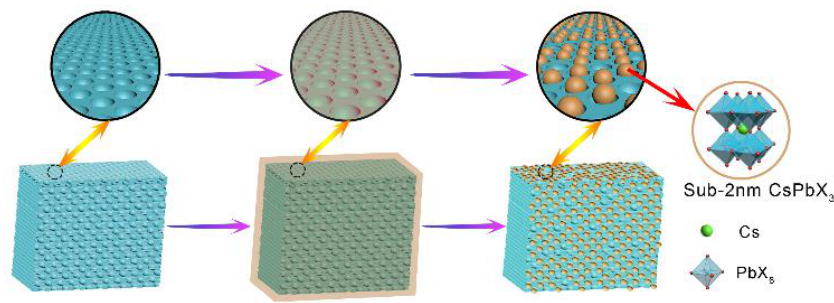
(MOF)-confined CsPbX 3 perovskite quantum Figure 1. The schematic illustration about the synthetic process of metal organic framework (MOF)- confined CsPbX 3 perovskite quantum dots.